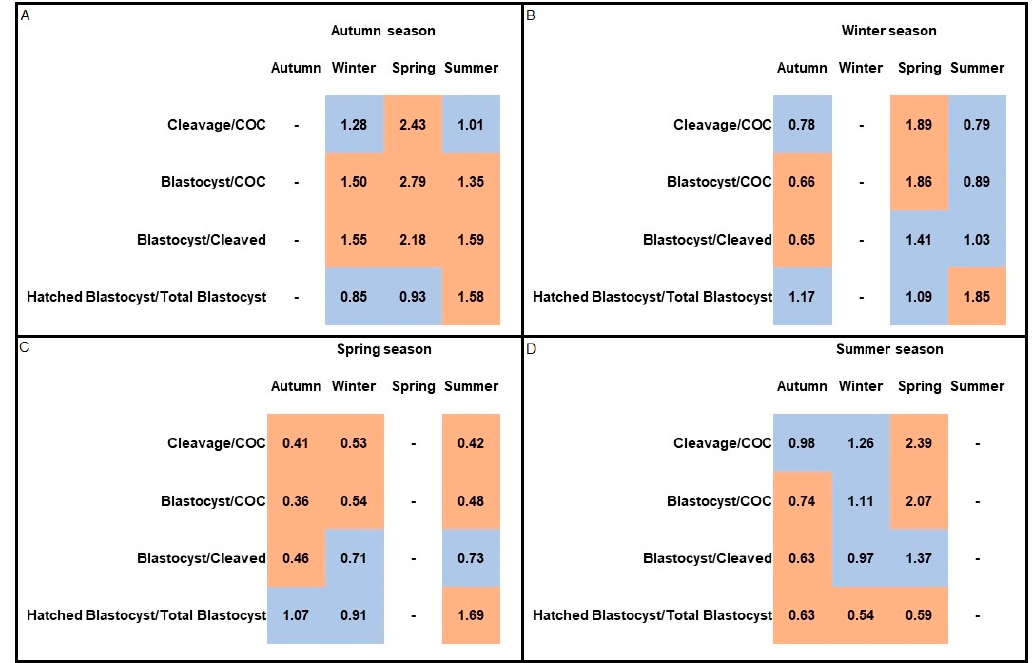
Figure 2. Heat map results of odds ratio (OR) of in vitro embryo production from adult goat oocytes in each season of the year for cleavage and blastocysts rates: ( A ) autumn season compared to all other seasons; ( B ) winter season compared to all other seasons; ( C ) spring season compared to all other seasons; and ( D ) summer season compared to all other seasons. The orange color indicates when the OR value was significant ( p < 0.05), while the blue color represents OR values that were not significant ( p > 0.05).